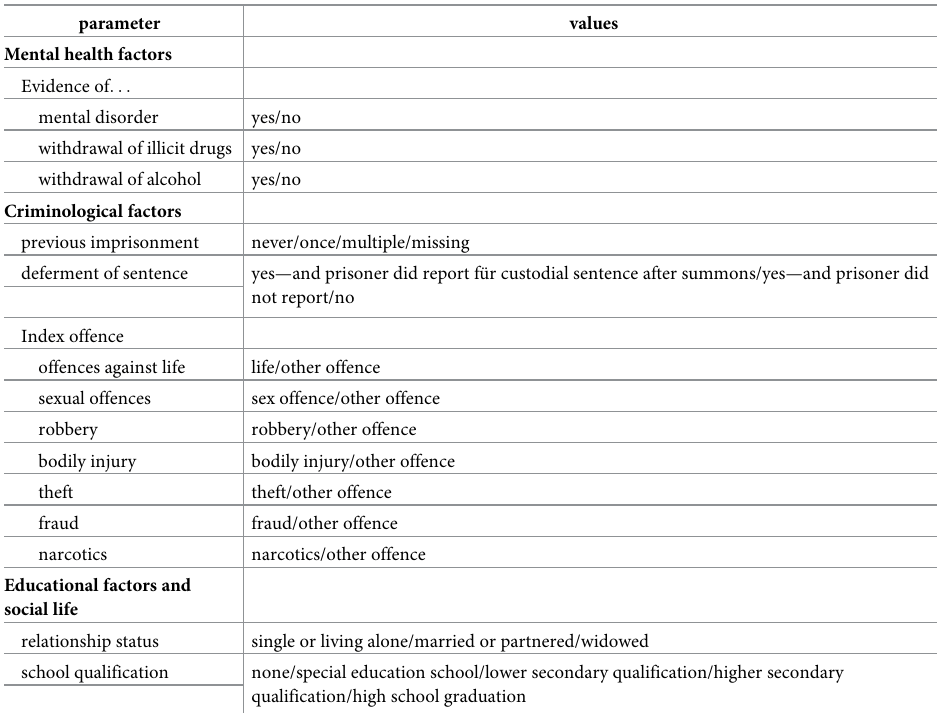
Table 1. Overview of factors with potential influence on the timing of prison suicide.